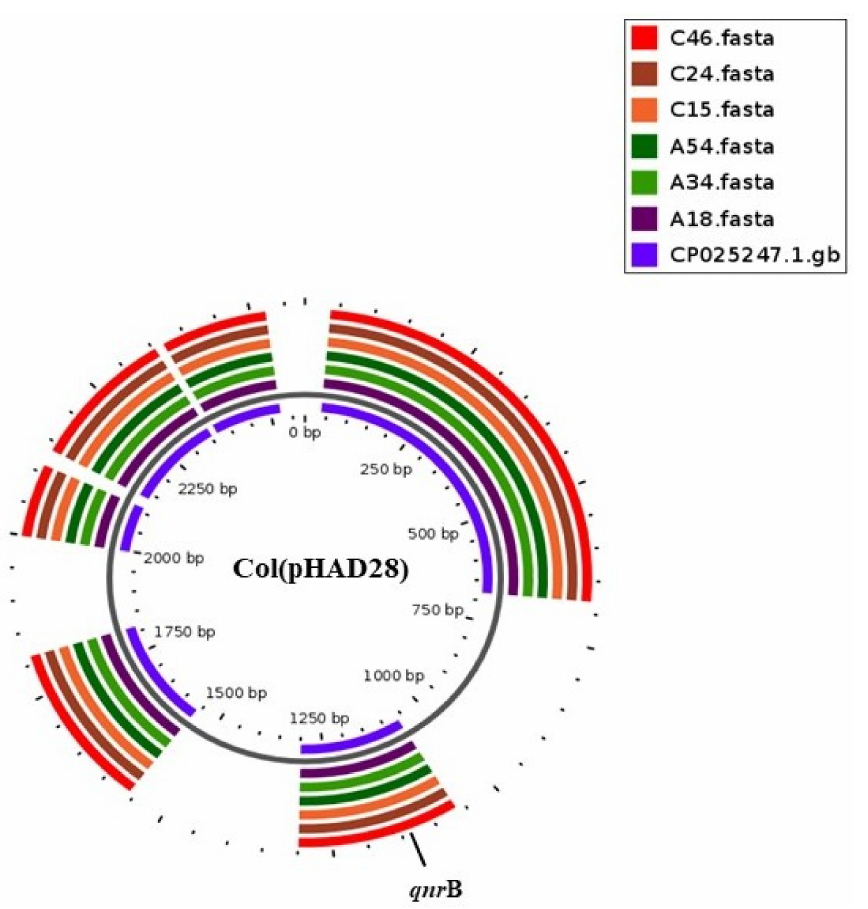
Figure 3. BLAST atlas created using GView of the Col (pHAD28) plasmid from S . Isangi carrying a plasmid-mediated quinolone resistance gene ( qnrB19 ) with the reference plasmid CP025247.1. The innermost ring represents the genes of the reference plasmid, while the three outermost rings are the query plasmids from this study. Genomic locations of resistance genes are